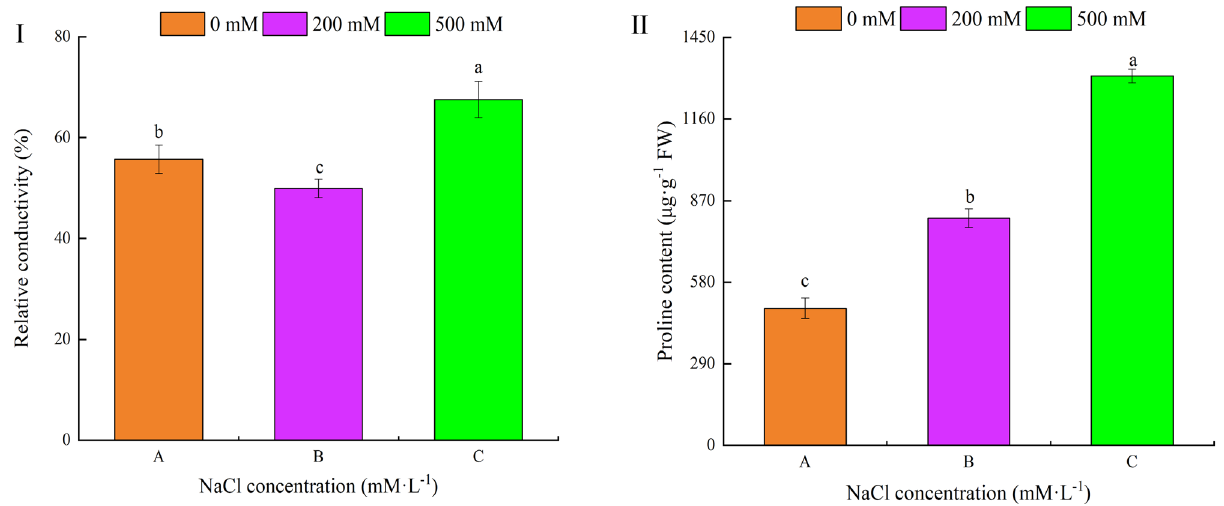
Figure 1. Effects of NaCl concentrations on the relative conductivity and proline content of R. soongorica leaves. I: relative conductivity II: proline content.